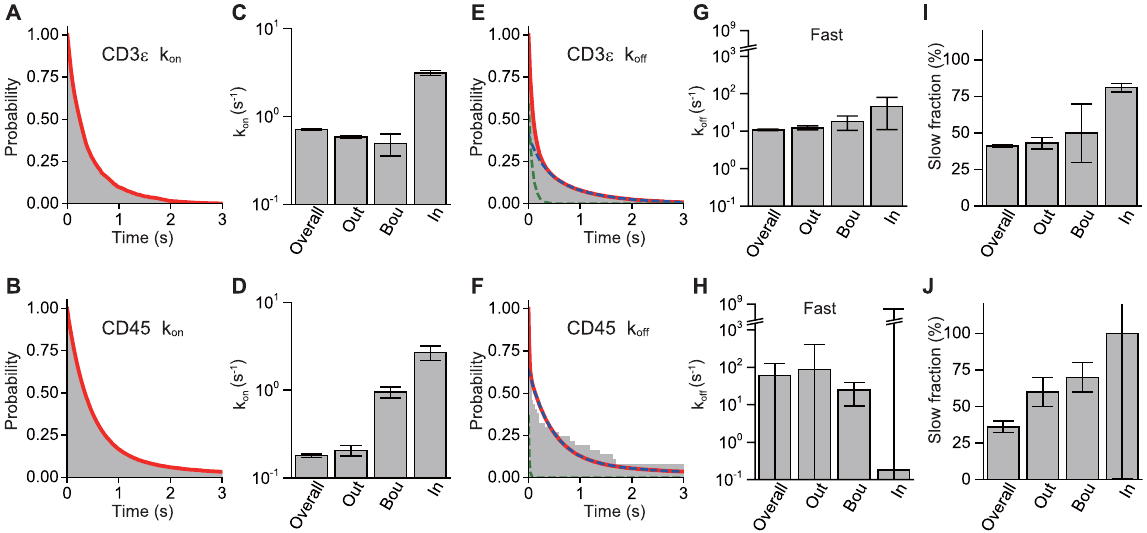
Figure 6. Heterogeneity in the interaction of CD3 ε and CD45 with the microclusters is found in dissociation but not in association, as revealed by kinetics analysis. ( A,B ) Cumulative distributions of the overall durations T fast of the dissociated state (faster mobility state) of CD3 ε ( A ) and CD45 ( B ). Overall data were obtained and analyzed without location classification. The distributions were well fitted by a single-exponential function in terms of the transition (Equation 12, red line), which gave overall association rates k on . ( C,D ) Association rates of CD3 ε ( C ) and CD45 ( D ). Location-classified association rates k on_in , k on_bou , and k on_out on the inside, at the boundary, and on the outside of the microclusters, respectively, were obtained in the same manner using Equation 13. ( E,F ) Cumulative distributions of the overall durations T slow of the associated state (slower mobility state) of CD3 ε ( E ) and CD45 ( F ). In contrast to the association rate analysis, the distributions were fitted by a double-exponential function in terms of the transition (Equation 14, red line), which gave slower overall dissociation rates k off_slow (blue dashed line) and faster overall dissociation rates k off_fast (green dashed line). ( G,H ) Faster dissociation rates of CD3 ε ( G ) and CD45 ( H ). Location-classified faster dissociation rates k off_in_fast , k off_bou_fast , and k off_out_fast on the inside, at the boundary, and on the outside of the microclusters, respectively, were obtained in the same manner using Equation 15. ( I,J ) Fraction ν of the slower dissociation of CD3 ε ( I ) and CD45 ( J ) (Equations 14 and 15). The relative occurrences of the slower and faster dissociations are ν and 1 − ν ,